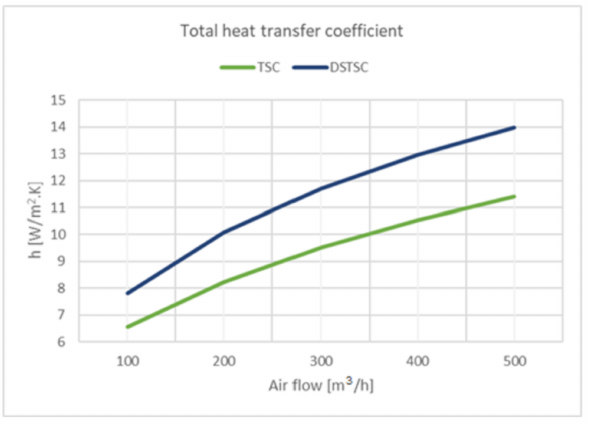
Figure 13. Computed results on the evolution of the total heat transfer coefficient for the TSC and